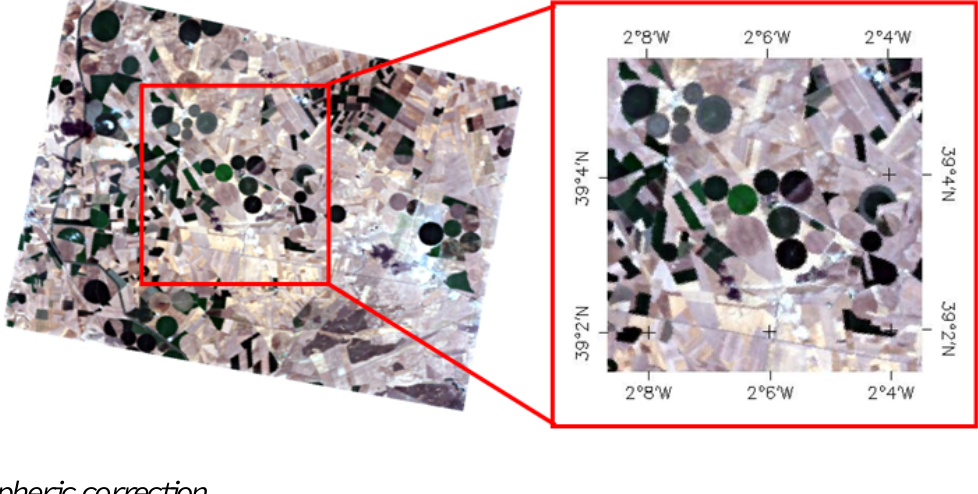
Figure 3. Test site as viewed by PROBA/CHRIS. The image shows a RGB composition in natural colour using CHRIS bands 25 (674.419 nm), 14 (563.373 nm) and 8 (501.531 nm). Green and dark tones are vegetated